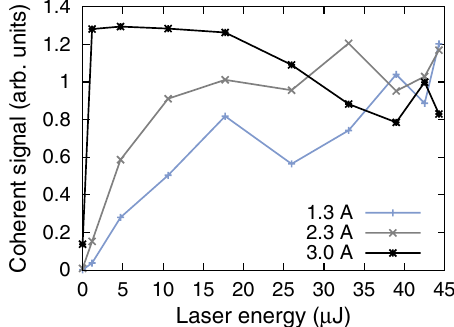
FIG. 9. Dependency of coherent signal at 133 nm on laser energy and chicane strength allows estimates of optimal parame- ters for energy modulation and